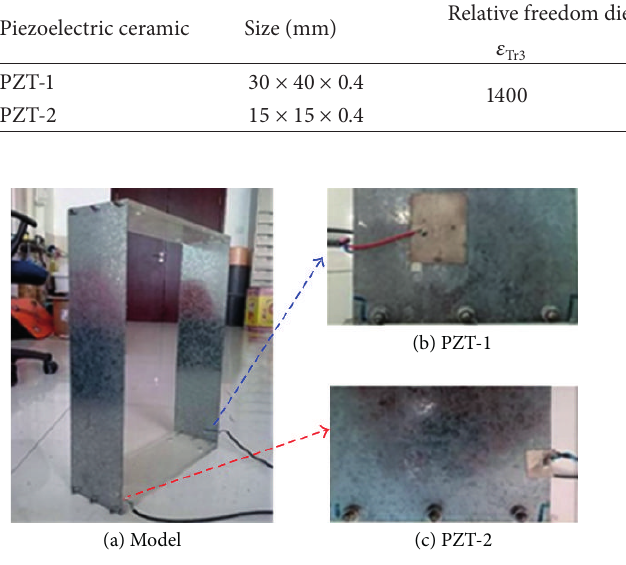
Figure 1: Structural model in test.